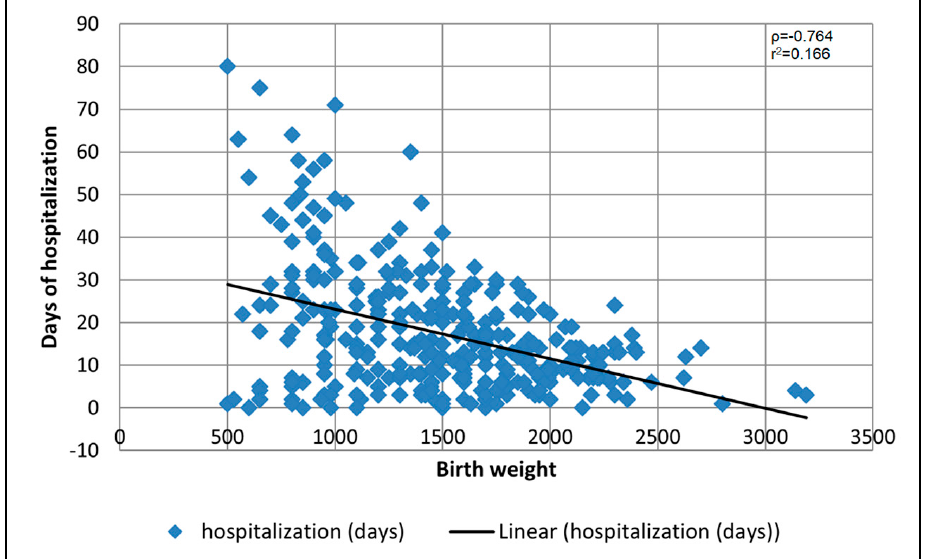
Figure 2. Dispersion chart with regression line of correlation between neonatal birth weight and hospitalization days.